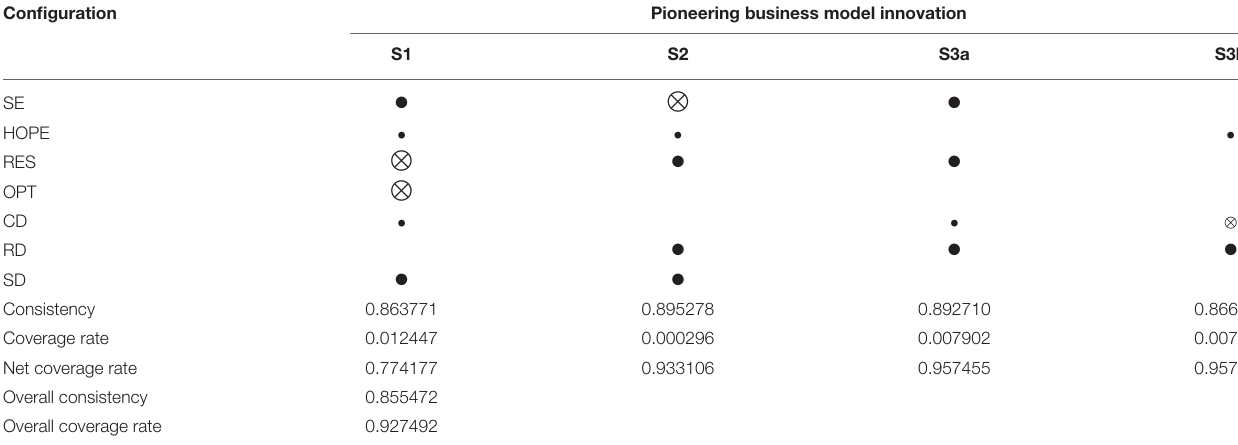
TABLE 6 | Pre-condition configuration of perfect business model innovation.